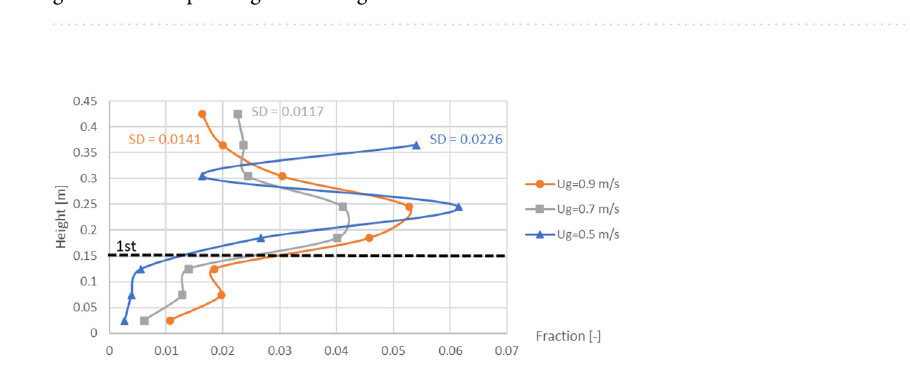
Figure 12. Effect of biomass feed position on time-and-area-averaged biomass fraction in case of the baffled gasifier when operating at various gas inlet velocities.